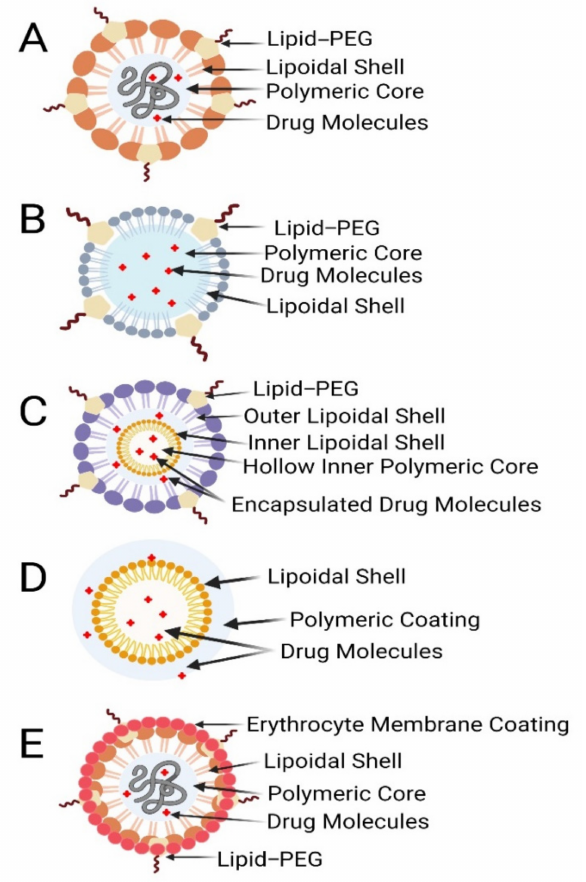
Figure 4. Different types of polymer–lipid hybrid nanoparticles. ( A ) Polymer core, lipid shell. ( B ) Polymer-caged nanobins. ( C ) Core shell-type hollow lipid–polymer–lipid hybrid nanoparticles. ( D ) Monolithic PLNs. ( E ) Erythrocyte membrane-coated